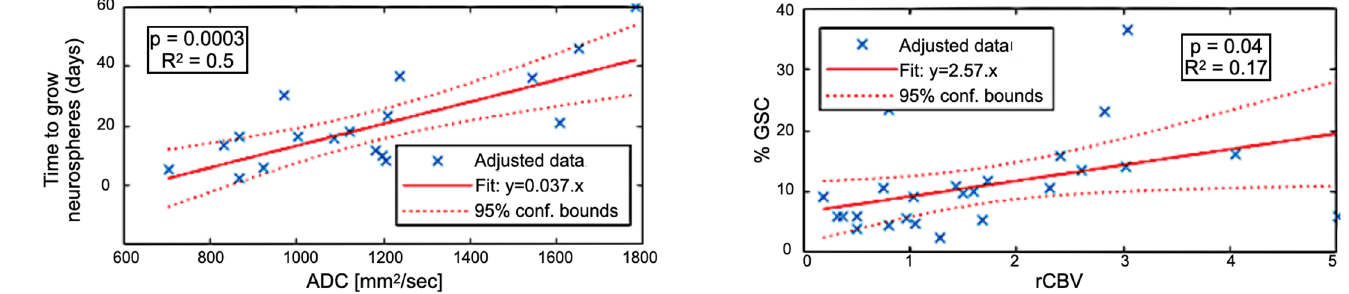
Figure 4. ( Left ) Correlation between the time to grow GSC neurospheres (in days) versus the ADC. ( Right ) Correlation between the proportion of GSC versus the relative Cerebral Blood Volume (rCBV).